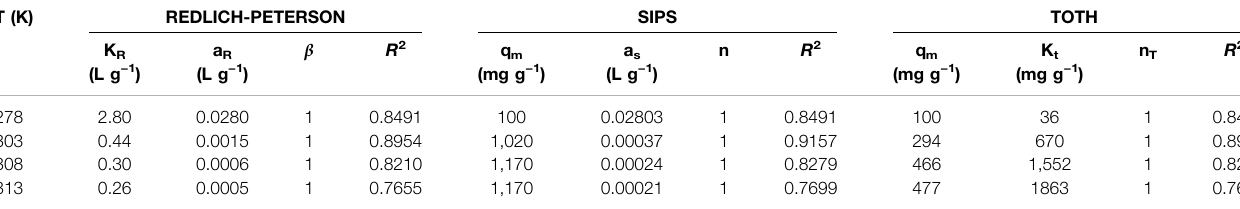
TABLE 3 | Redlich-Peterson, Sips and Toth adsorption isotherm values and correlation coef fi cients. T (K) REDLICH-PETERSON SIPS TOTH